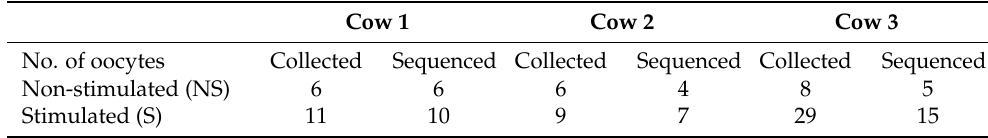
Table 4. Number of oocytes collected and sequenced for each animal from non-stimulated and stimulated cycles. Cow 1 No. of oocytes Collected Sequenced Collected Sequenced Collected Sequenced Non-stimulated (NS) Stimulated